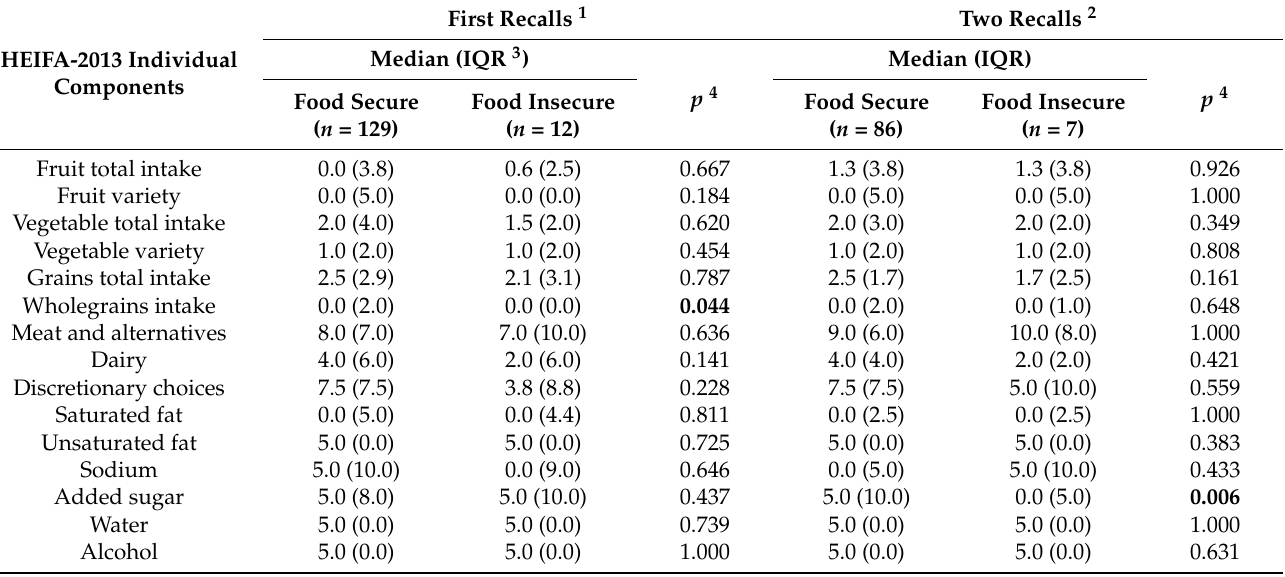
Table 4. Median scores of individual components of Healthy Eating Index for Australian Adults (HEIFA-2013) by food security status among students attending a large Australian